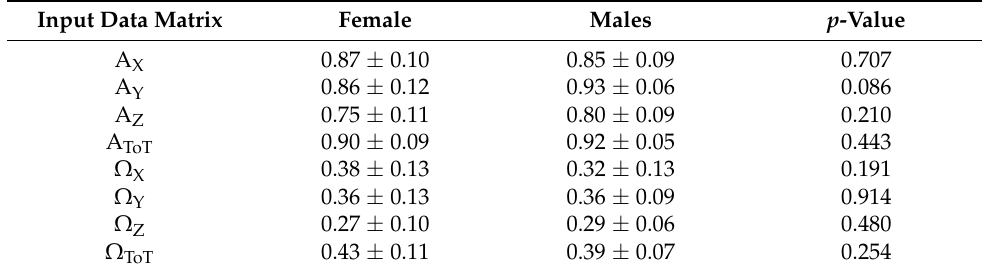
Table 2. Pearson correlation coefficient between best-matching retained PCs and V CW (mean ± standard deviation). The p -value is the outcome of the unpaired t -test comparing the effect of the factor gender on the independent variables. The p -values are highlighted in bold when reaching significance ( p <